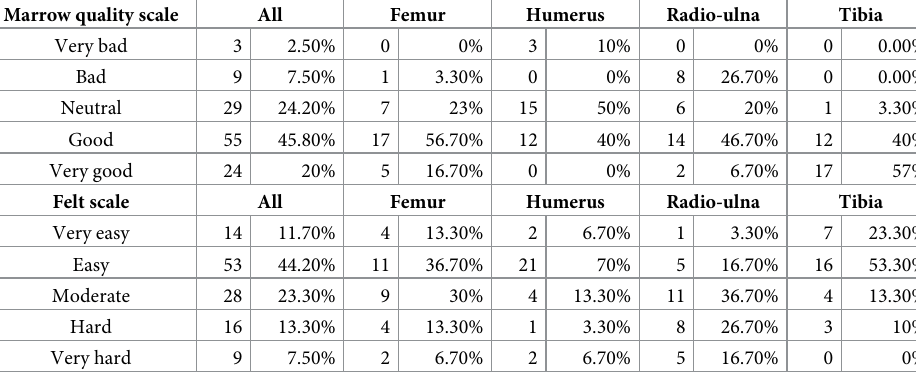
Table 5. Scales of difficulty felt during the experiment and of the marrow quality auto-evaluated by the experi- menters themselves for all the elements and for each